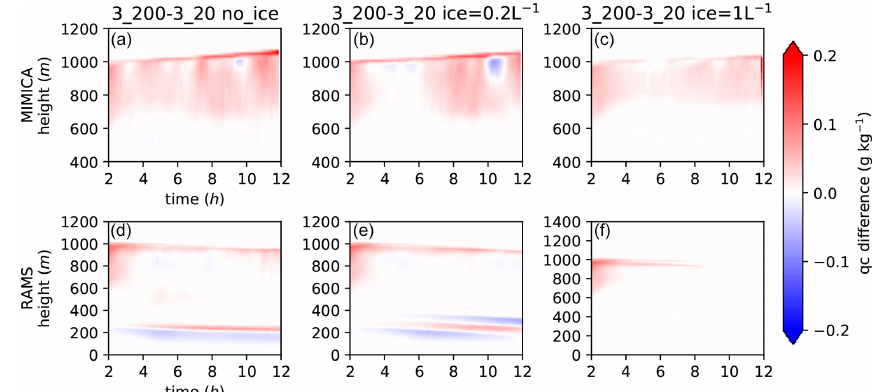
Figure 11. Differences in cloud water mixing ratio (qc) for simulation pairs with the same accumulation mode concentration and the same ice crystal concentration equal to 0L − 1 (no_ice; a, d ), 0.2L − 1 (b, e) and 1L − 1 (c, f) , shown for MIMICA and RAMS. The first 2h of simulations, considered as the spin-up period, are excluded. A Student’s t test with a 95% confidence level shows that the (time mean) differences are statistically significantly different for each pair of simulations. For figure clarity, the plot titles have been abbreviated; the first number refers to the accumulation mode and the second to the Aitken mode concentration in cubic centimetres, i.e. 3_20 refers to AC3_AK20.